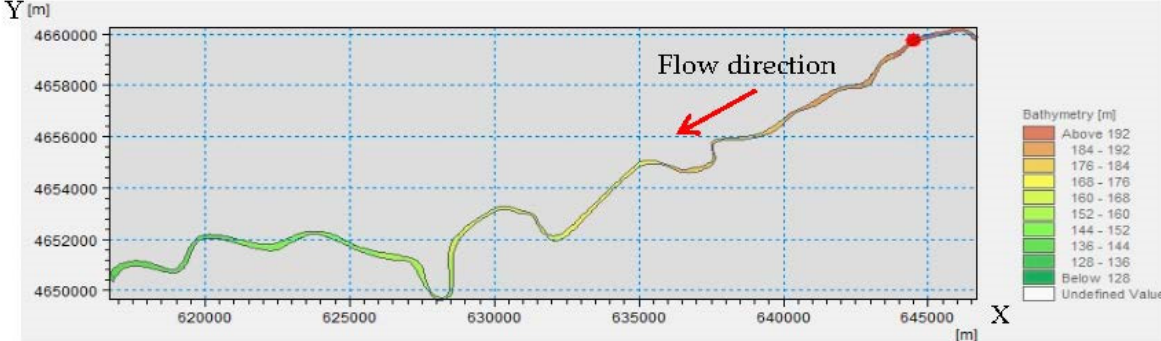
Figure 5. Location map of heavy metal iron pollution source.